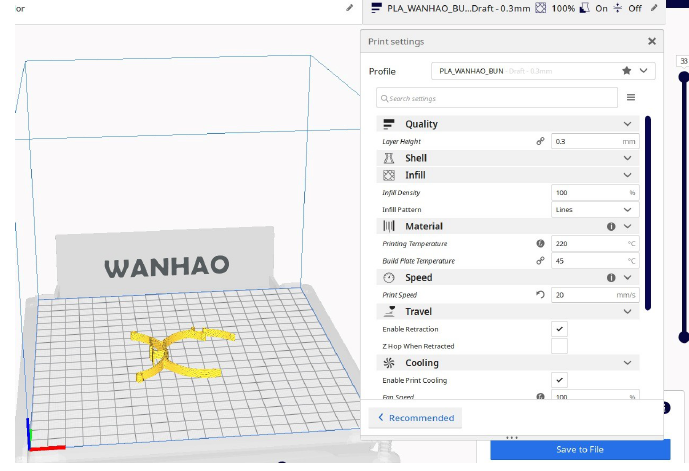
Figure 8. Working parameters used for compliant mechanism.